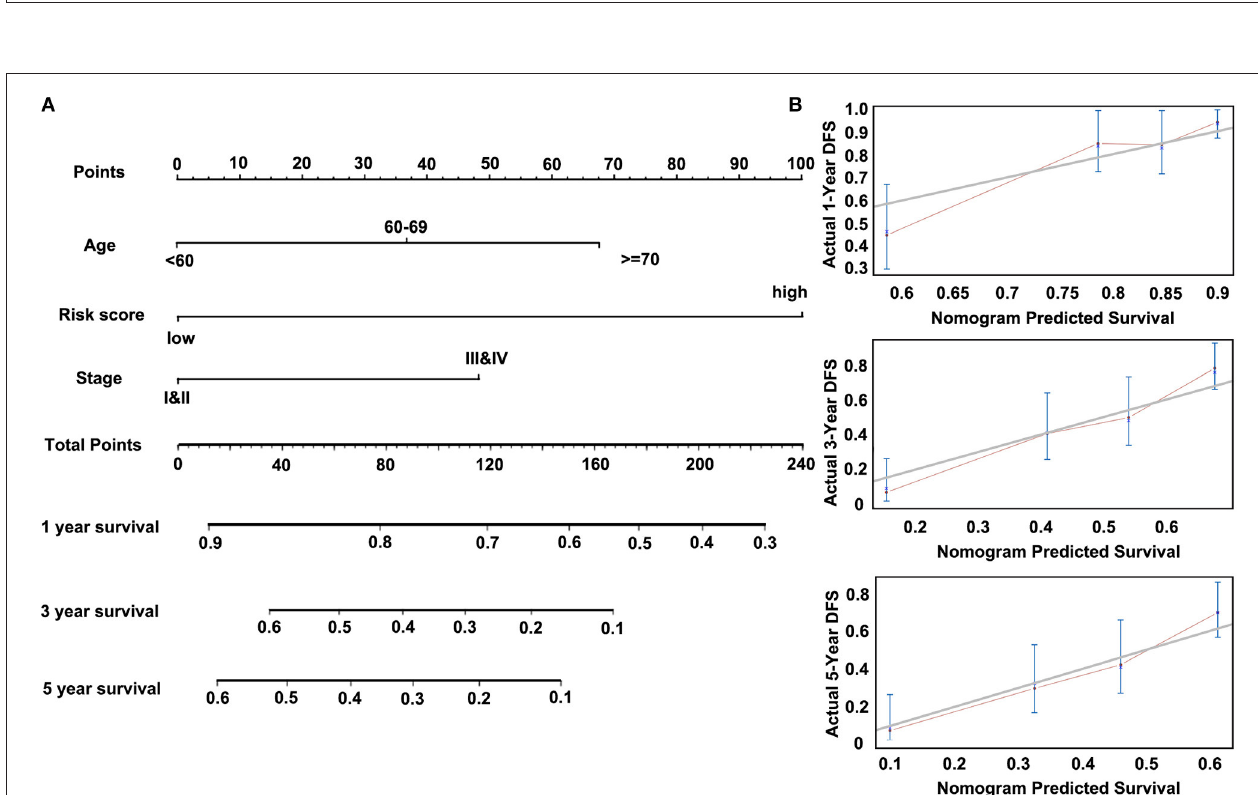
FIGURE 7 | Nomogram of Cox regression model in the discovery cohort (GSE53624). (A) The nomogram for predicting overall survival (OS). (B) The calibration plots for predicting 1-, 3-, and 5-year OS.